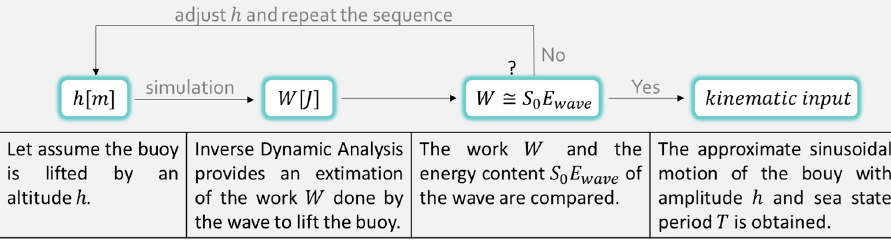
Figure 4. Basic concept of the energy balance algorithm (EBA).